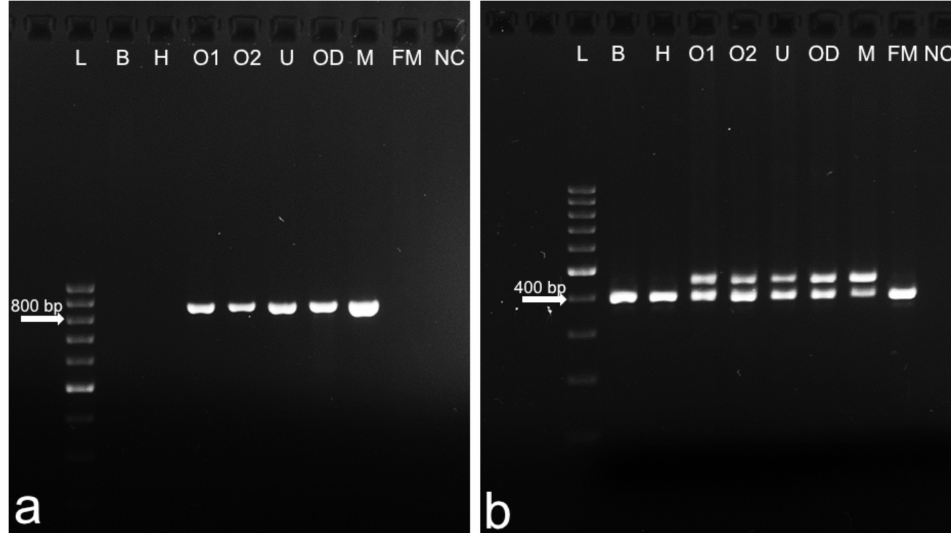
Figure 4. Detection of SRY ( a ) and ZFY ( b ) genes in DSD heifer #7514. L: GeneRuler DNA ladder; B: blood; H: hair follicles; O1: ovary 1; O2: ovary 2; U: uterus; OD: oviduct; M: control male; FM: control female; NC: negative control (no